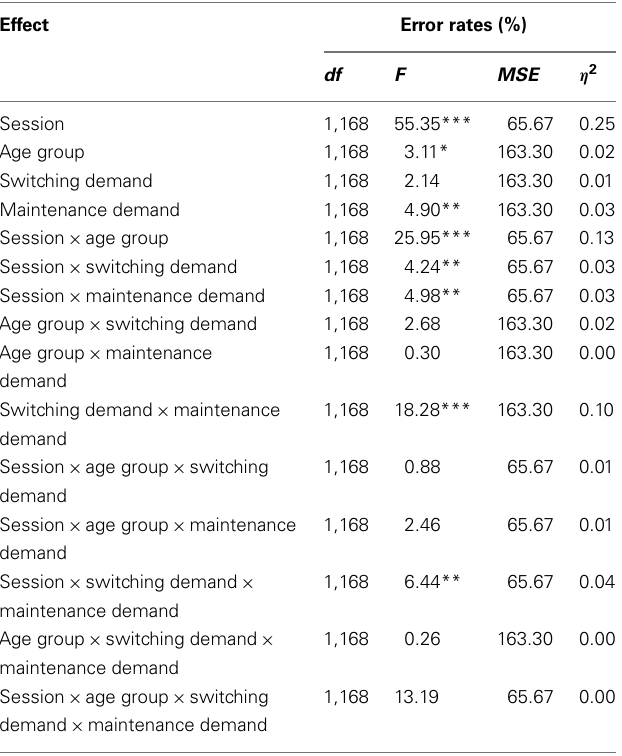
Table 3 |Analysis of variance results for the pretest and posttest data based on error rates (%) for the Maintenance demand and for the Switching demand groups.